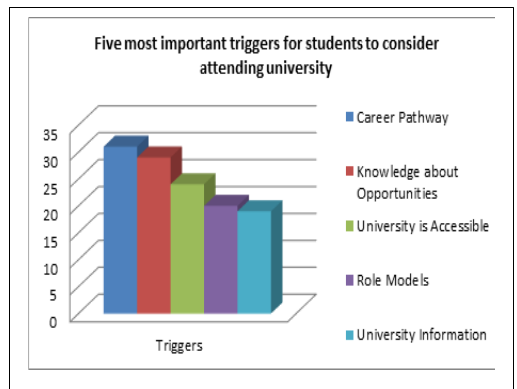
Figure 1 : The five most important triggers, identified by teachers